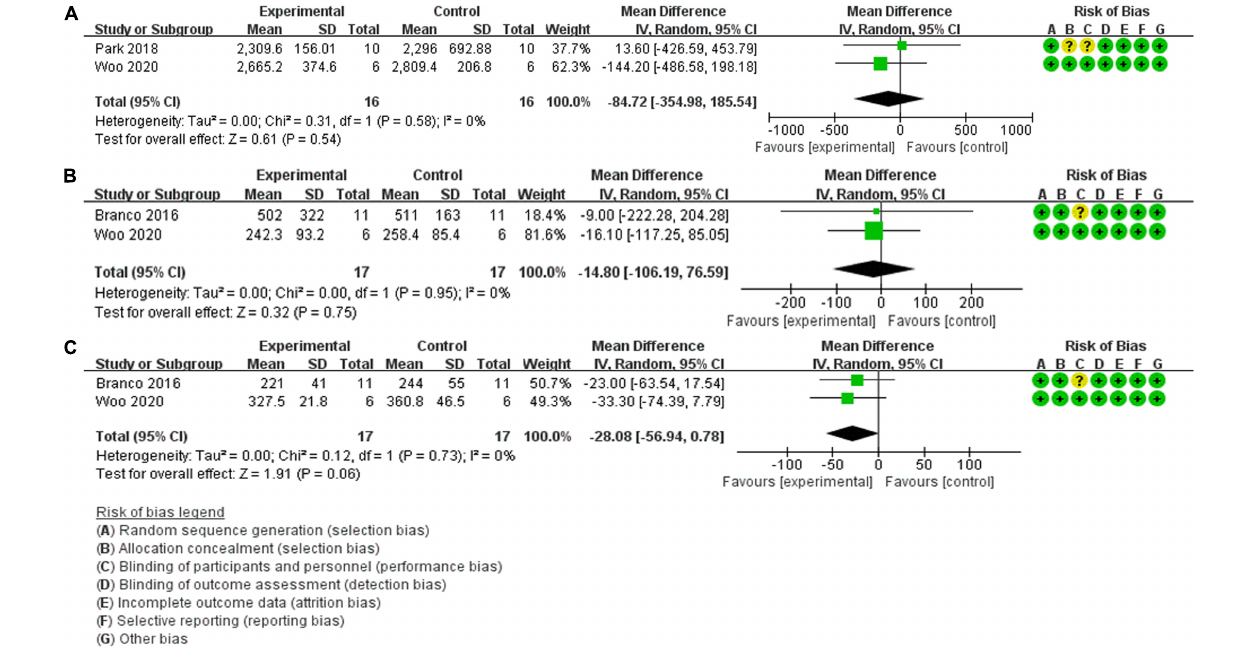
FIGURE 3 | Forest Plot of the Comparison of the effects of post-exercise HBO 2 on recovery. (A) Biological antioxidant potential index, (B) creatine kinase index, (C) lactate dehydrogenase